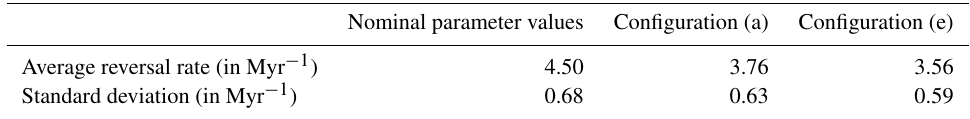
Table 7. Average reversal rate and standard deviation of an ensemble of 10 5 simulations of duration 10Myr, filtered to a resolution of 30kyr. The simulations are done with nominal parameter values (Table 3) or the posterior mean values of configurations (a) and